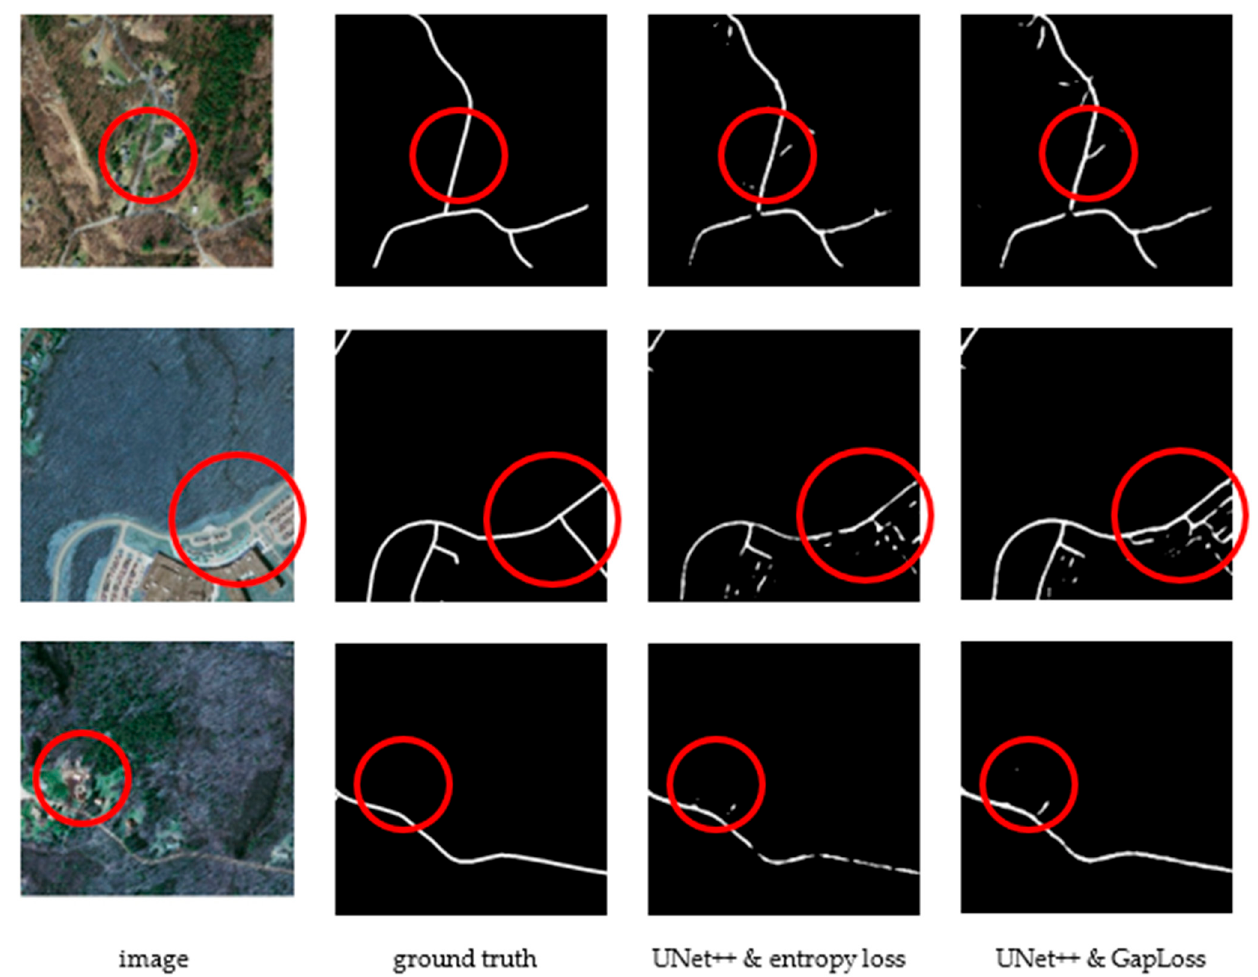
Figure 14. Some controversial misjudgments.